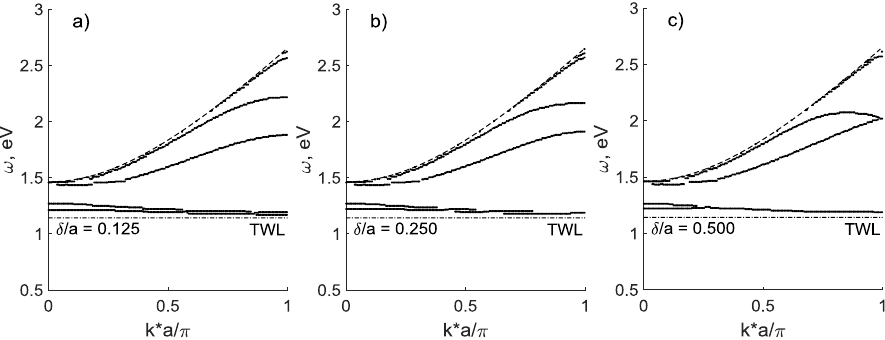
Fig. 4. The dispersion law for the guided modes with the different relative shift of cylinder